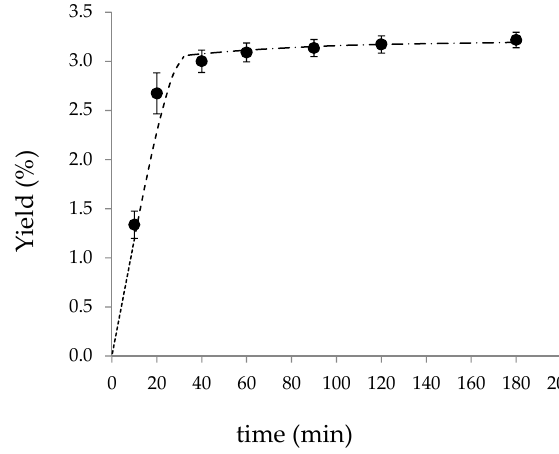
Figure 1. Kinetic behavior of Mortiño SFE at 313 K and 30 MPa in the small-scale extraction cell (273 cm 3 ) and with CO 2 mass flow Q SS = 32 g·min − 1 . ( ● ) experimental data. Solid lines represent the BIC model fitting: ( ¨¨¨¨¨¨ ) CER period; (- - -) FER period; (- ¨ - ¨ ) DC period. Table 2. Experimental yield (%) obtained in the kinetic study of SFE of Vaccinium meridionale Swartz (Mortiño) at 313 K and 30 MPa in the low-scale extraction cell (273 cm 3 ). CO 2 flow = 32 g·min − 1 . Yield (%) Time (min) Standard Deviation ( SD ) * Kinetic 1 Mean